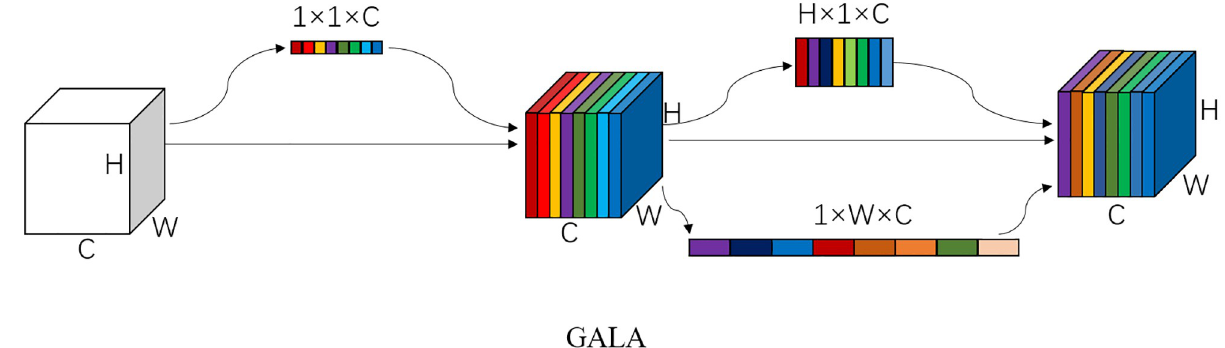
Fig 9. The scheme depicts the GALA mechanism. C represents the number of channels, that is, the number of feature maps. H and W represents the height and width of the feature maps, respectively.